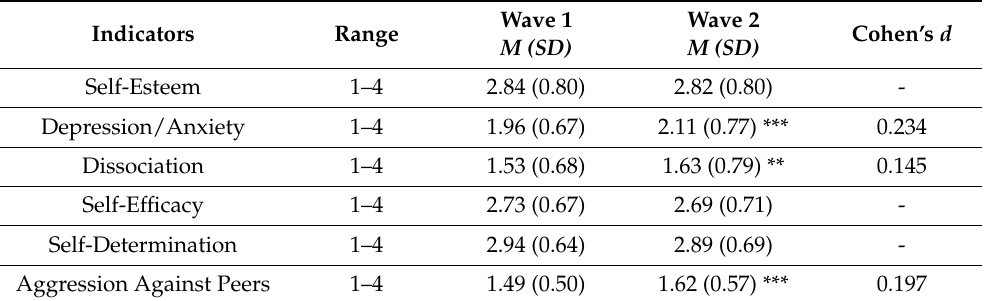
Table 2. Paired t -tests, wave 1 ( n = 523) and wave 2 ( n = 560) sub-sample mean levels (and standard deviations) of all six latent class/latent transition